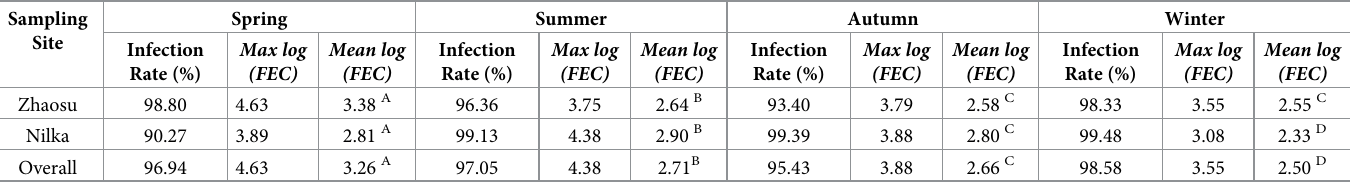
Table 3. Sheep GIN infection rate (%) and Log (FEC) of different regions for various seasons. Sampling Site